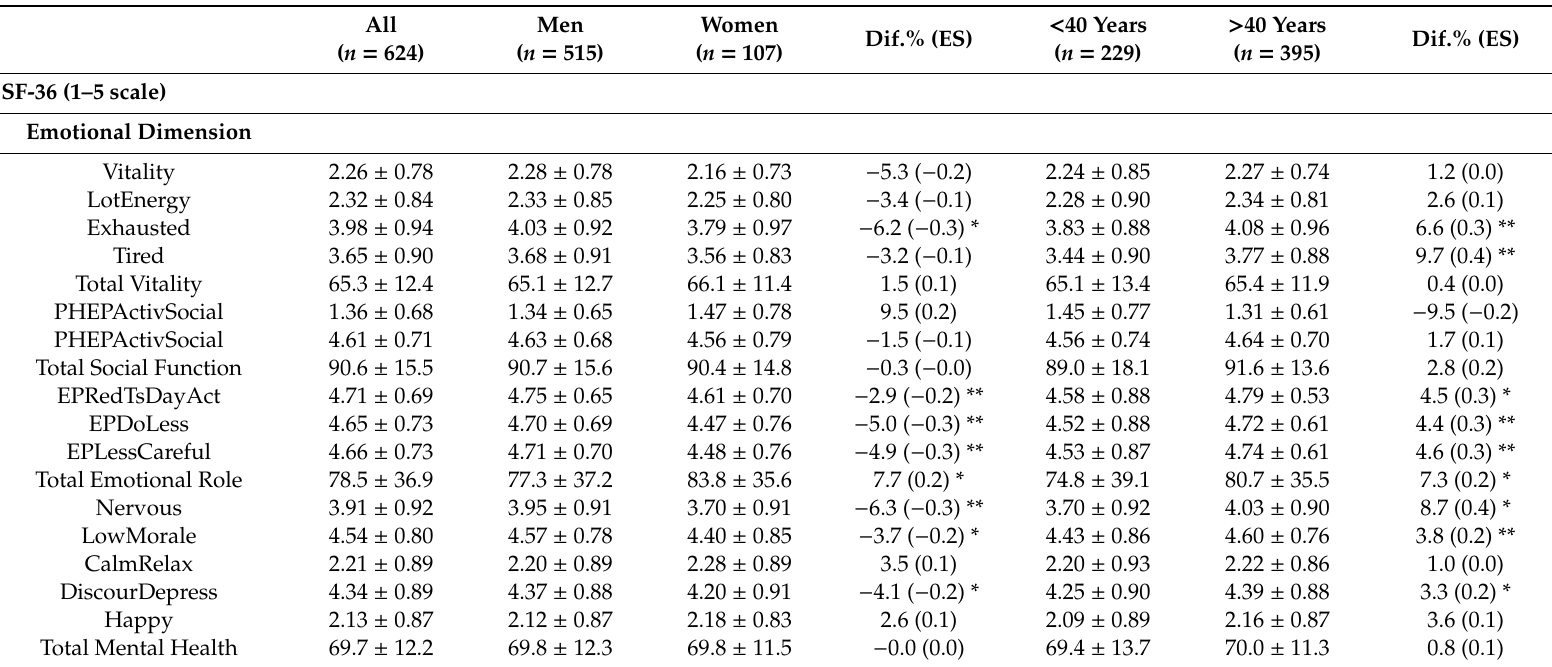
Table 3. Results obtained for the Emotional dimension of the SF-36 questionnaire by the amateur half-marathon runners participating in the study and based on the sex and age of the participants ( < 40 and > 40